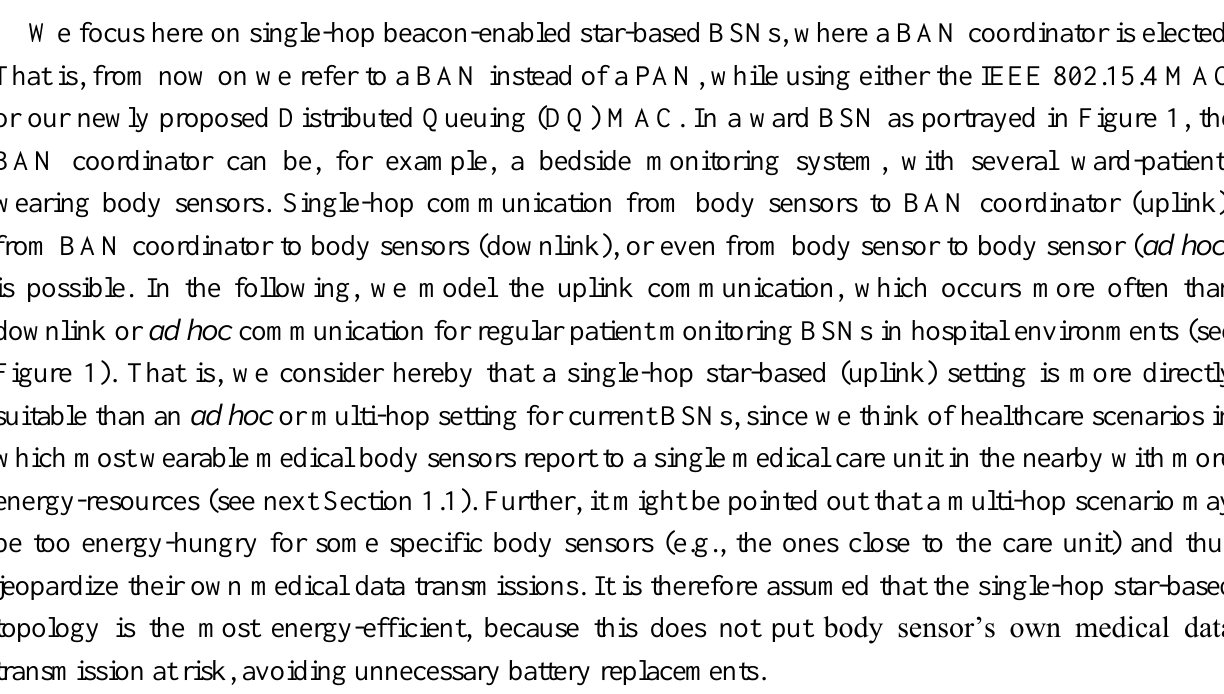
Figure 1. A star-based BSN in a potential medical